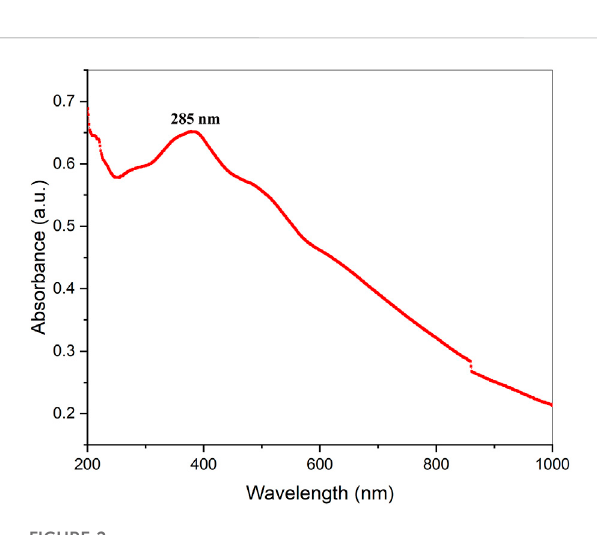
FIGURE 2 UV-Vis absorption spectrum of biogenic CuO